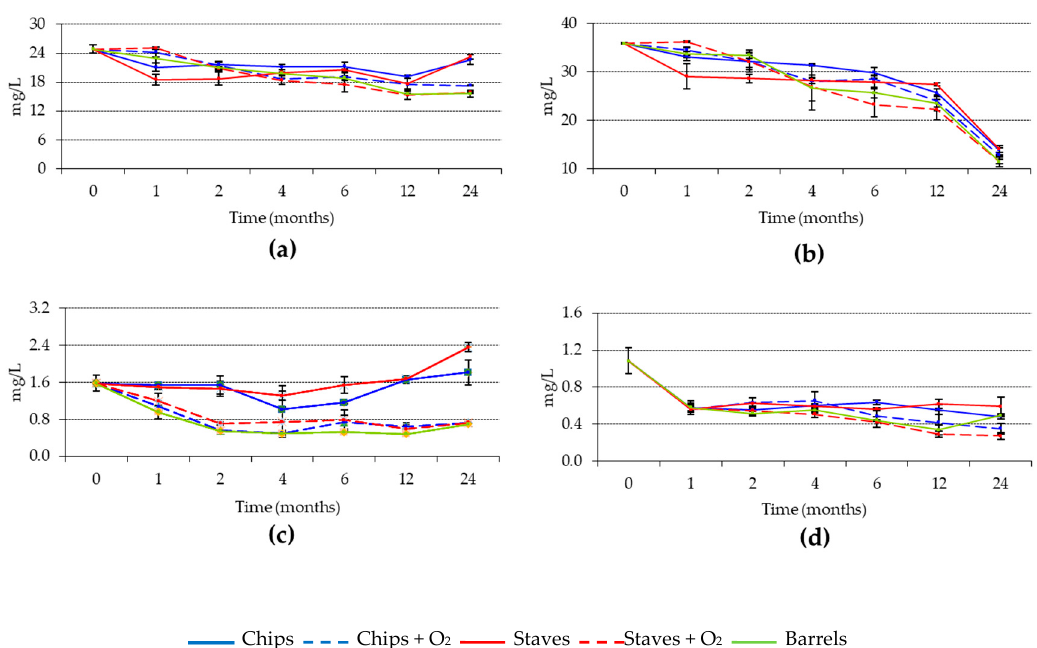
Figure 7. Evolution over time of flavanols concentration (mg/L): ( a ) catechin and ( b ) epicatechin; and of flavonols concentration (mg/L): ( c ) quercetin and ( d ) rutin. Mean ± standard deviation ( n = 2).